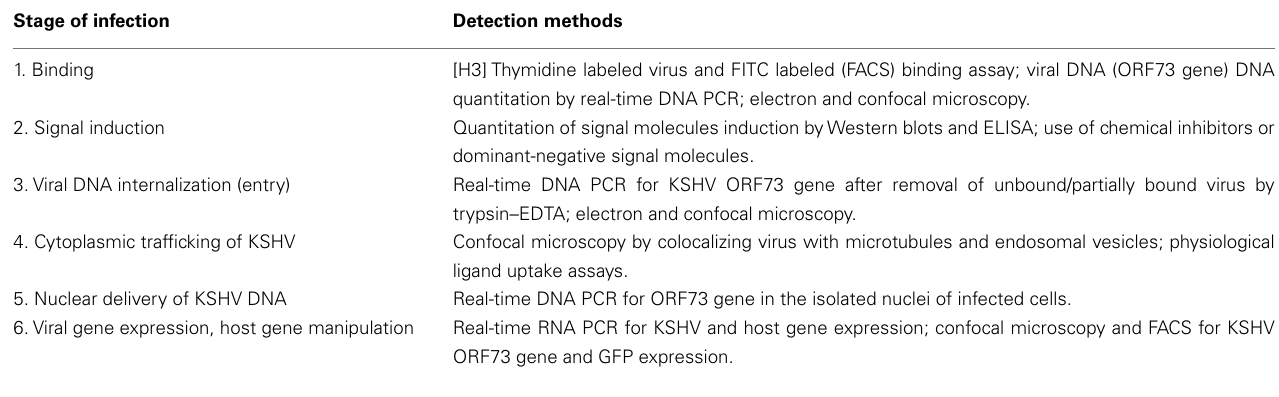
Table 1 | Methods employed to study the various stages of in vitro KSHV infection. Stage of